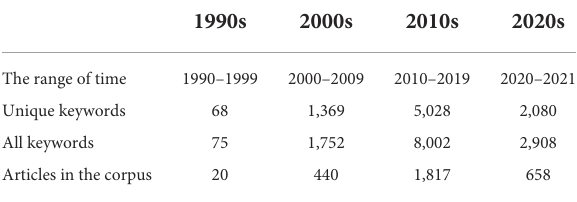
TABLE 1 The total number of articles in each era and the number of keywords